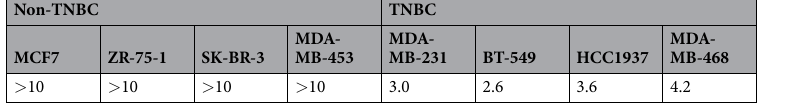
Table 1. Mean IC50 values ( μ M) of chelerythrine on breast cancer cell